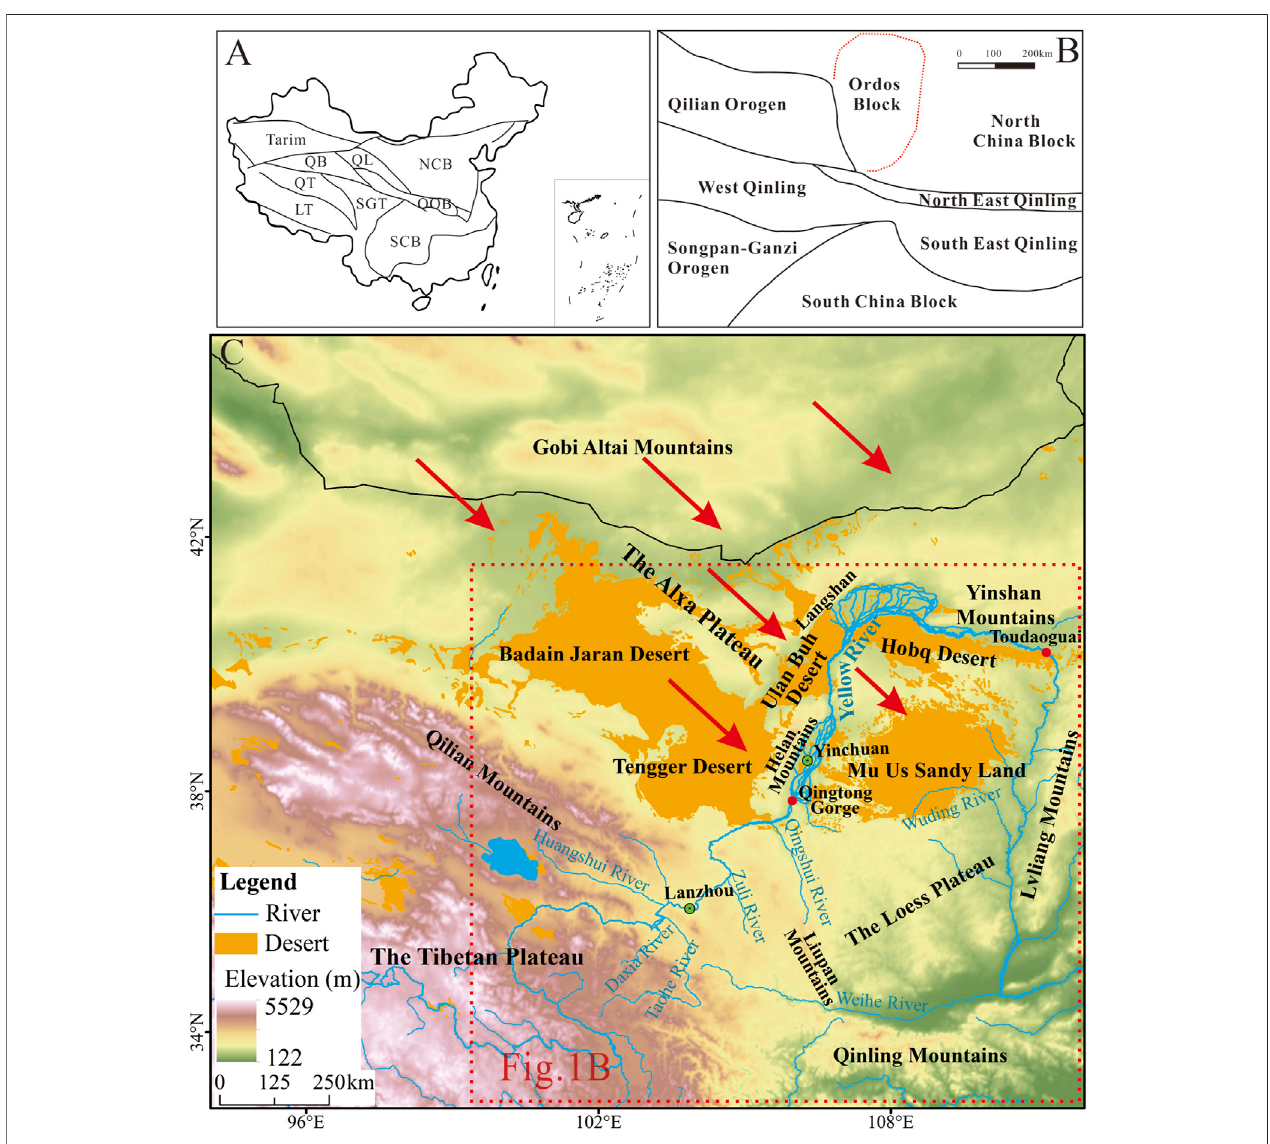
FIGURE 1 | (A) Simpli fi ed geological map of China. (NCB: North China Block; SCB: South China Block; SGT: Songpan-Ganzi terrane; QB: Qaidam Basin; QT: Qiangtangterrane;LT:Lhasaterrane;QOB:QinlingOrogenicBelt). (B) Simpli fi edregionalgeologicalmapofstudyarea(modi fi edafterZhuetal.,2011). (C) Geographical location of the Ordos Deserts. The red arrows refer to the dominant wind